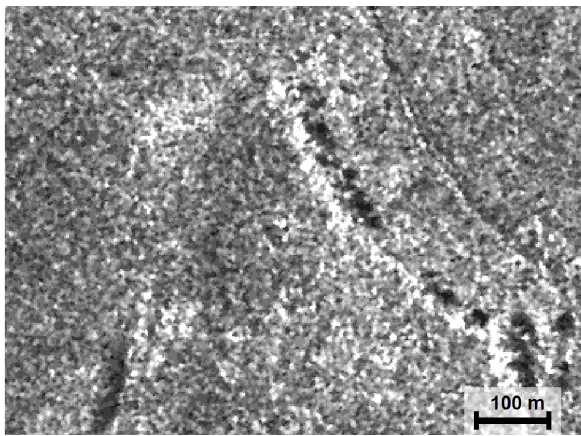
Figure 7. TerraSAR-X Spotlight image (vv) from 09.06 2012 for the same subset than Figure 5